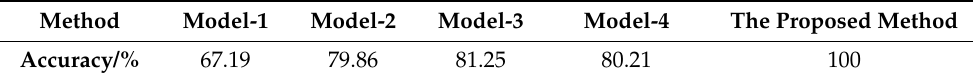
Table 5. Test results of an ungrounded system.